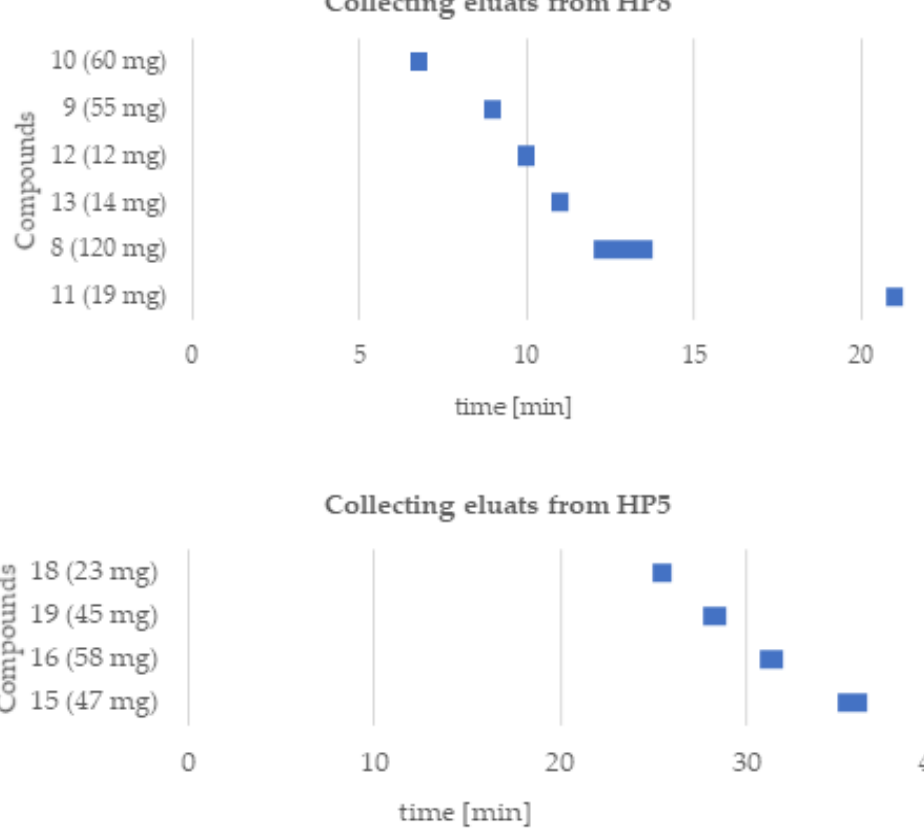
Figure 4. Time windows for collecting eluates from purification of chloroform fraction ( HP8 ) and n -butanol fraction ( HP5 ) by preparative HPLC.